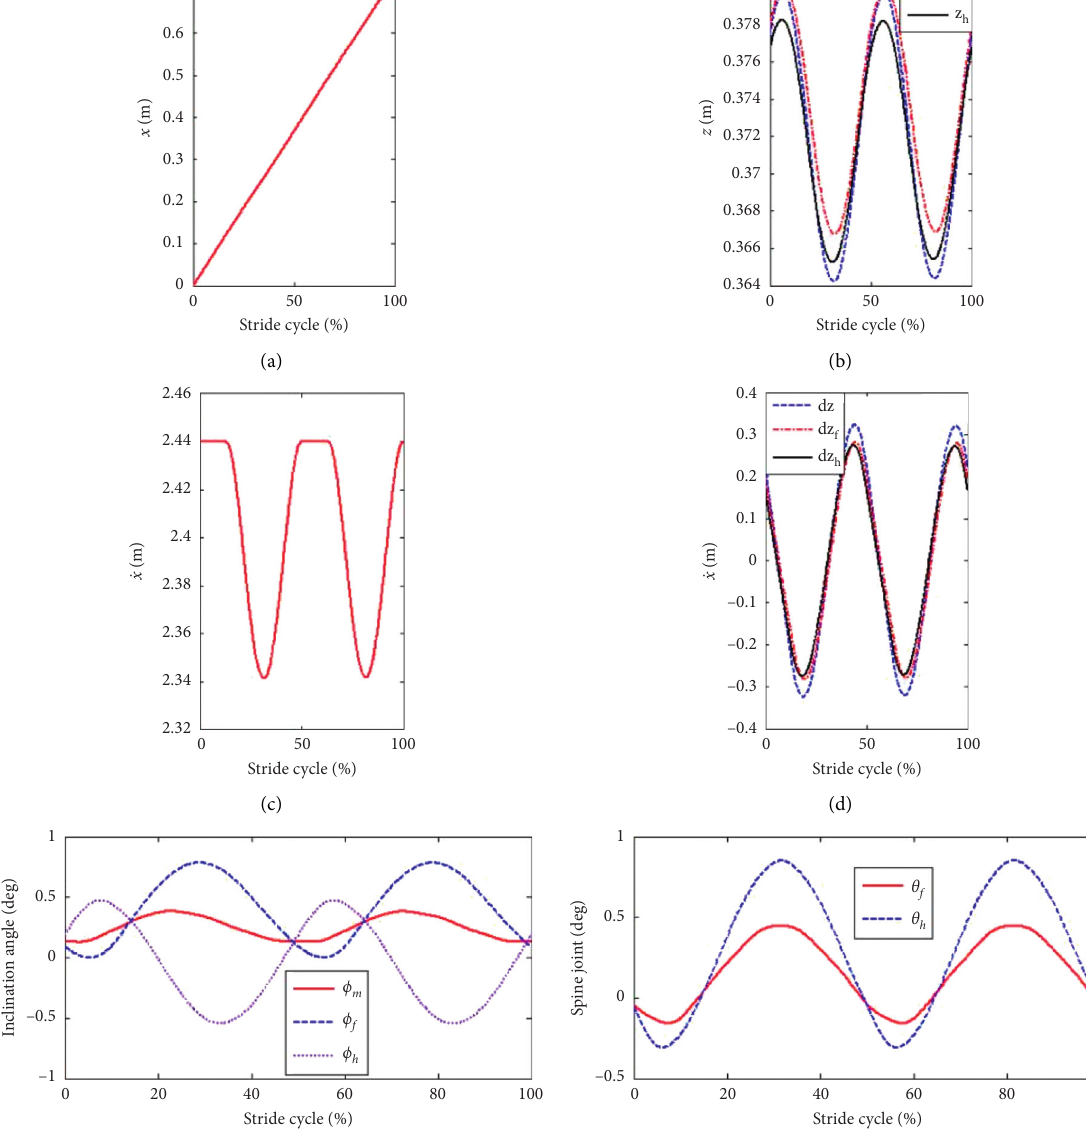
Figure 4: Dynamic behavior of the model with two spinal joints at 2.44m/s. (a) Horizontal displacement of middle body, (b) vertical displacement of three bodies, (c) horizontal velocity of middle body, (d) vertical velocity of three bodies, (e) inclination angle of three bodies, and (f) the rotation angle of two spinal